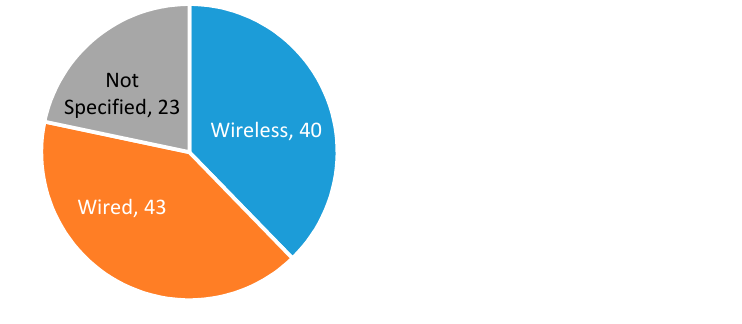
Figure 20. Number of studies adopting wired or wireless data transmission in respiration sensing systems.